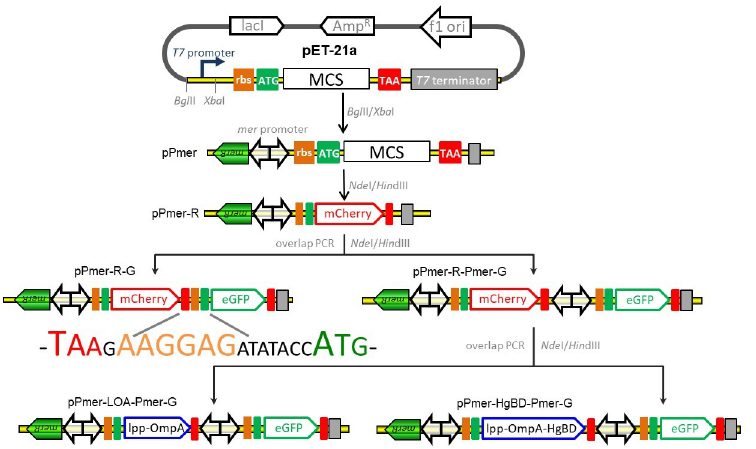
Fig 1. Assembly of artificial mer operons for biosensing and adsorption of Hg(II). The fluorescent reporter modules and bioadsorption module were placed under the control of the mer promoter separately or in combination. The DNA sequence containing the stop codon of the upstream gene, an extra RBS, and the start codon of the downstream gene is shown.